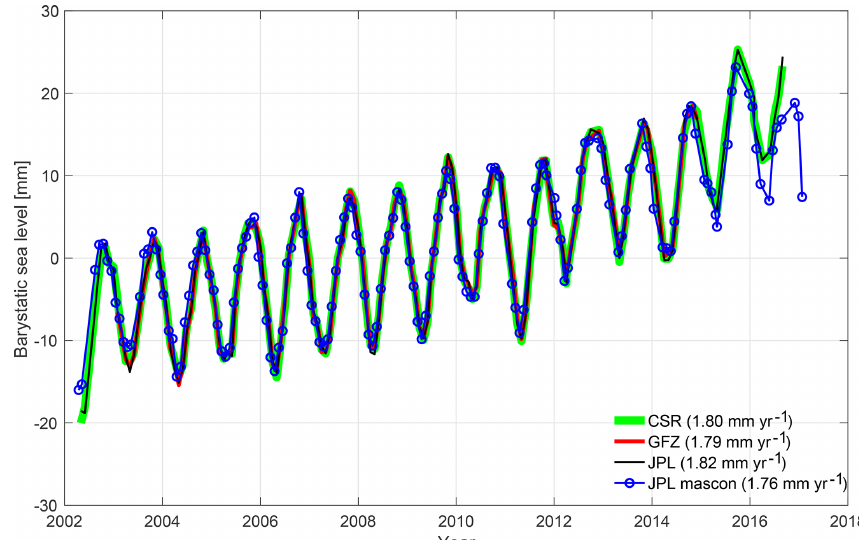
Figure 1. Barystatic sea-level time series. Our estimates of trends and seasonal amplitudes for all three data centers are compared to JPL mascon solutions (Watkins et al., 2015). Results are plotted relative to the time means over the period January 2003 through December 2013. Trend values are provided for the period January 2005 through December 2015, except for GFZ solutions (January 2005 to December 2013), for a comparison to the sum of individual mass components (during January 2005 to December 2016) listed in Table 13 of the WCRP (2018) report: 1 . 65 ± 0 . 23mmyr − 1 . As an additional point of comparison, Dieng et al. (2015) find GRACE-determined mass changes for the barystatic sea-level trend at 2 . 04 ± 0 . 08mmyr − 1 for January 2005–December 2013 from the mean of CSR, GFZ, and JPL Level-2 Release-05 spherical harmonic